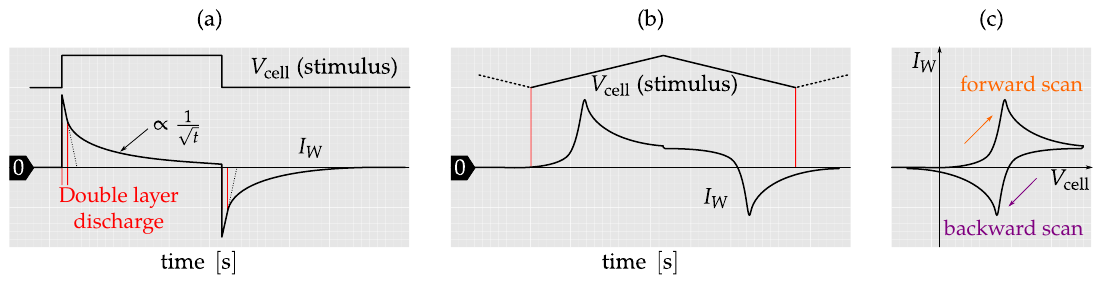
Electrochemical experiments: ( a ) chronoamperometry (versus potential step); ( b ) chronoamperometry (versus potential scan); ( c )